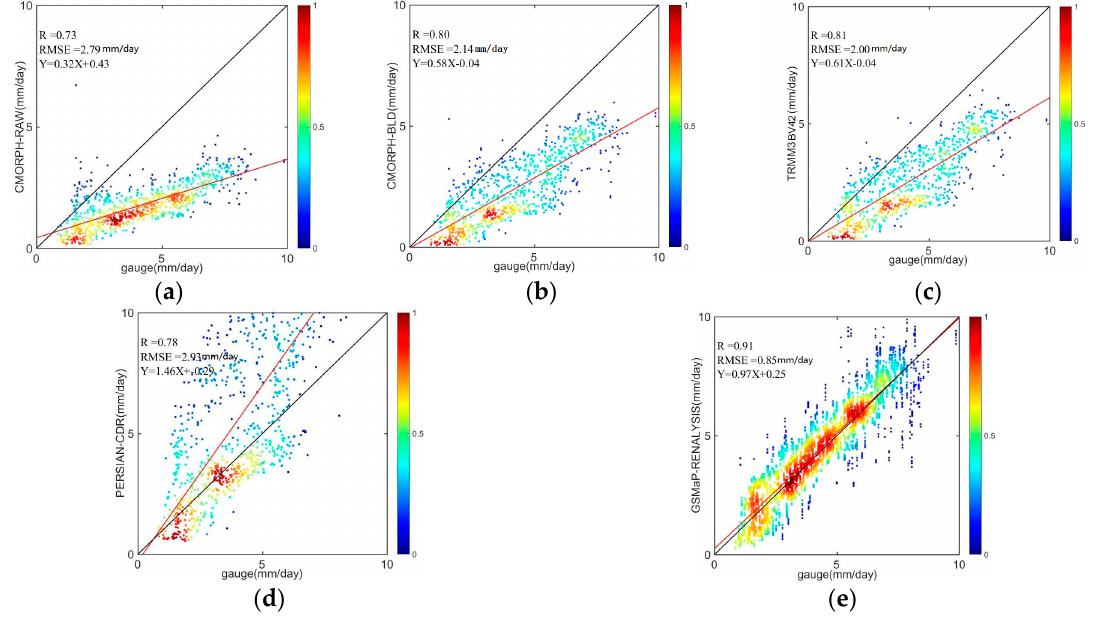
Figure 3. Density-colored scatterplots of the different products against the in-situ measurements for the nine-year mean daily precipitation. The red line is the fit and the black is 1:1. ( a ) denotes CMOPRH_RAW &gauge, ( b ) denotes CMOPRH_BLD &gauge, ( c ) denotes TRMM3BV42 &gauge, ( d ) denotes PERSIANN_CDR &gauge, ( e ) denotes GSMaP_RENALYSIS